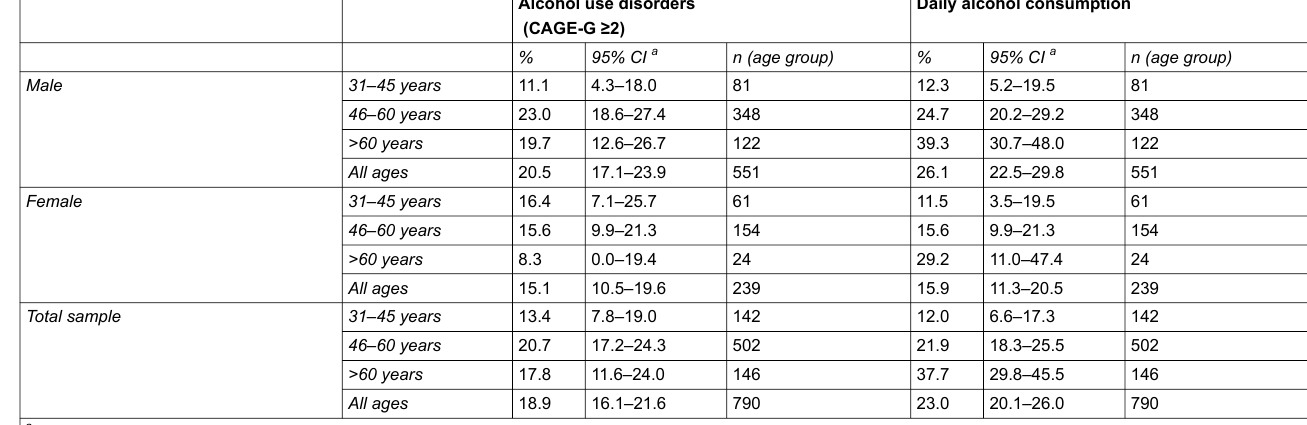
Table 3: Relative frequency of alcohol use disorders and daily alcohol consumption (in %, missings